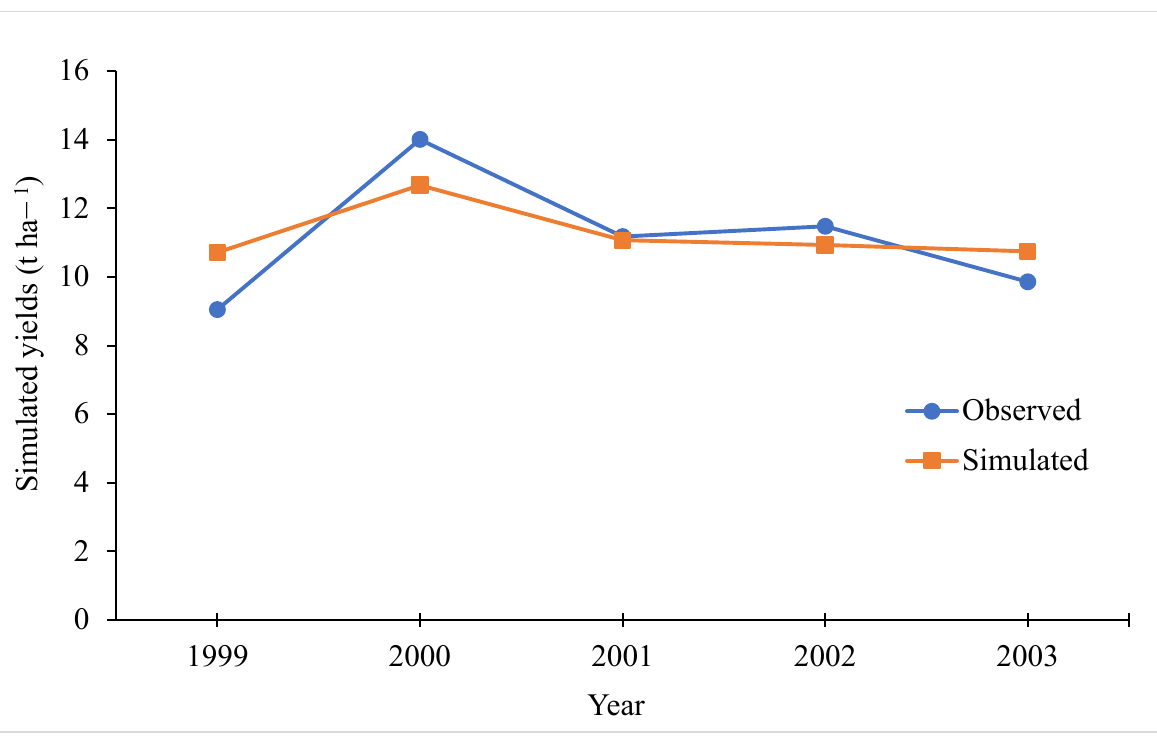
Figure A3. Simulated yields in the validation simulation using the calibrated model (figure obtained from [32]).